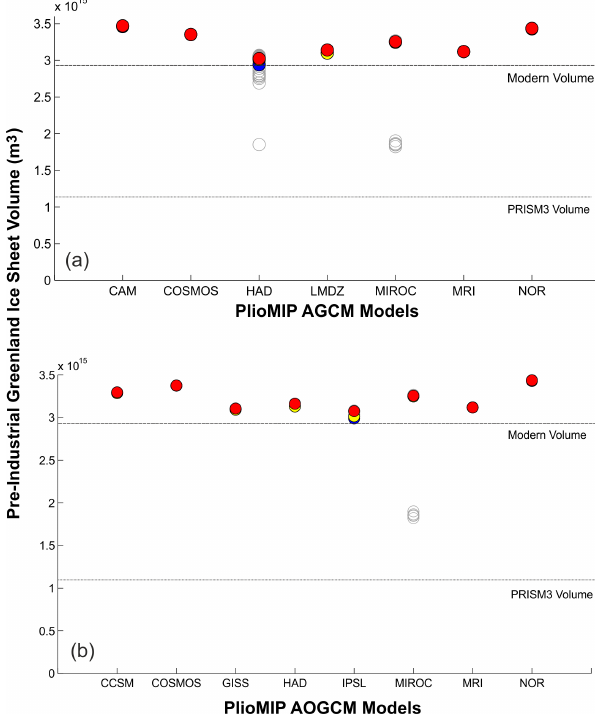
Figure 5. Simulated GrIS volume when BASISM is forced with the pre-industrial climatology from each of the (a) AGCM and (b) AOGCM PlioMIP models. The volume of the observed present- day GrIS (Bamber et al., 2001) is shown for comparison. Red- filled circles show the standard parameter set used within BASISM ( ∝ i = 8mmday − 1 ◦ C − 1 and ∝ s = 3mmday − 1 ◦ C − 1 , lapse rate = − 6 ◦ Ckm − 1 ) and blue-filled circles show the parameter set that gives a volumetric reconstruction closest to observed. Yellow-filled circles show the parameter set that gives the lowest RMSE in terms of thickness. Grey circles show the sensitivity of the ice sheet vol- ume to different values of lapse rate and the PDD factors for ice and snow (see Table 2). The coloured circles are superimposed on the grey circles, so when the GrIS volume is similar, the grey circles (or individual colours) will not be